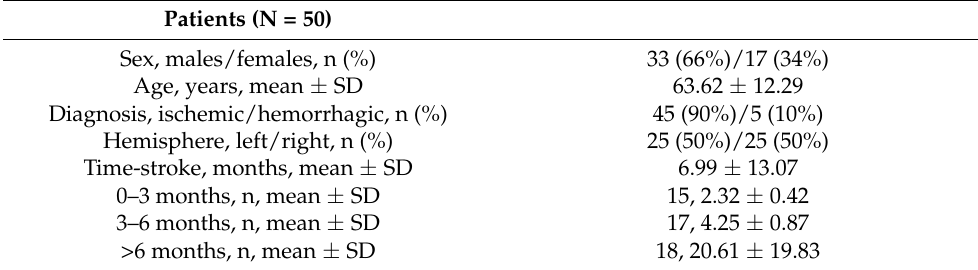
Table 1. Demographic and clinical characteristics of the